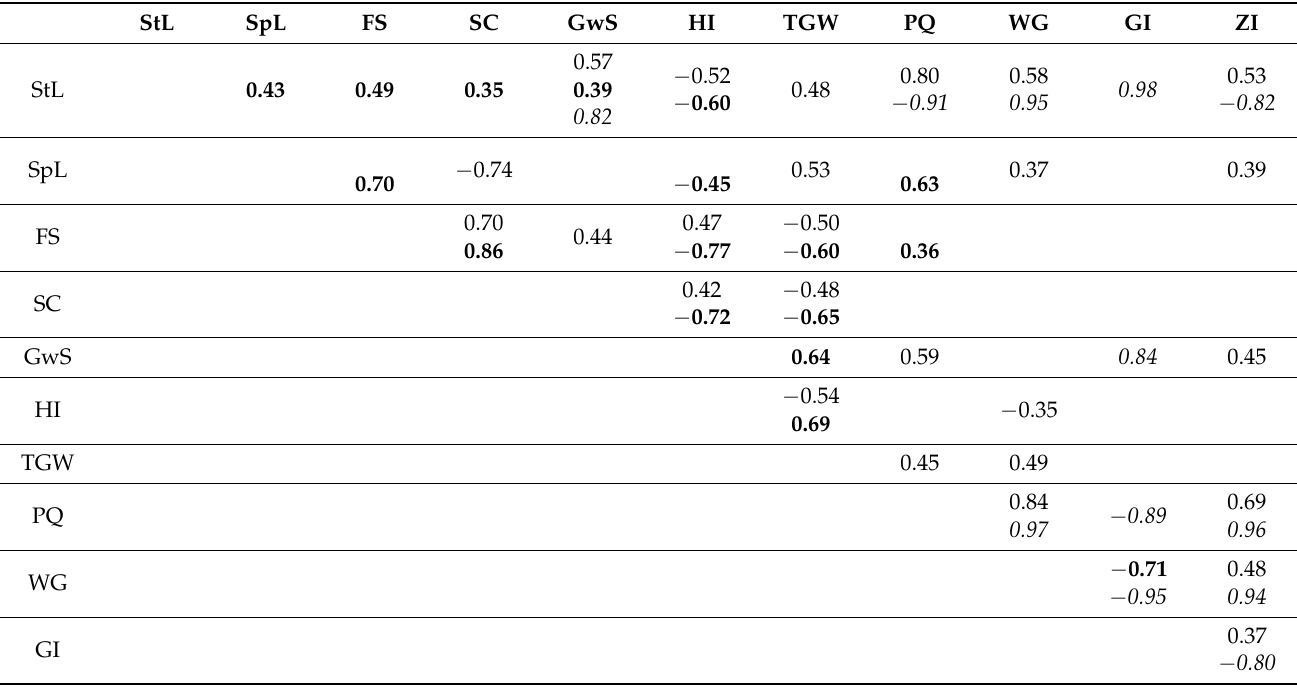
Table 5. Correlation analysis of plant, spike traits, yield components and grain quality traits of spelt, emmer (bold) and einkorn